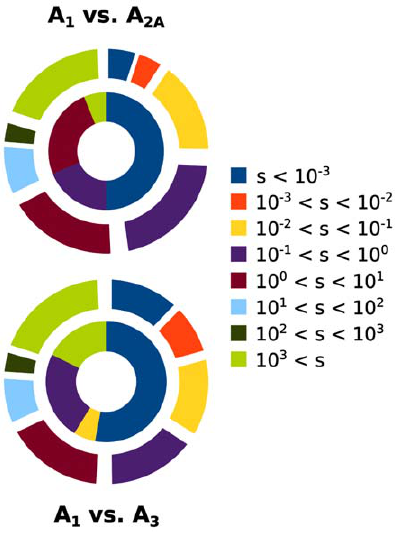
Figure 3. Comparing the selectivity of ligands from this work with ChEMBL data. Selectivity statistics for experimentally measured affinities of molecules from the ChEMBL database (outer shell) and our screen (inner donut). Selectivity ratios have been binned into log-sized bins, ranging from more than 1000-fold selectivity in either direction to